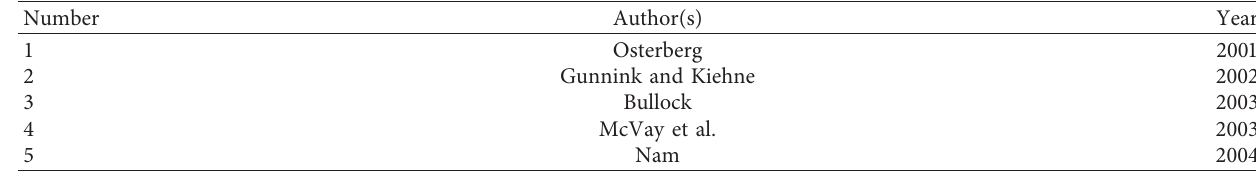
Table 8: Authors and years for references in the present study